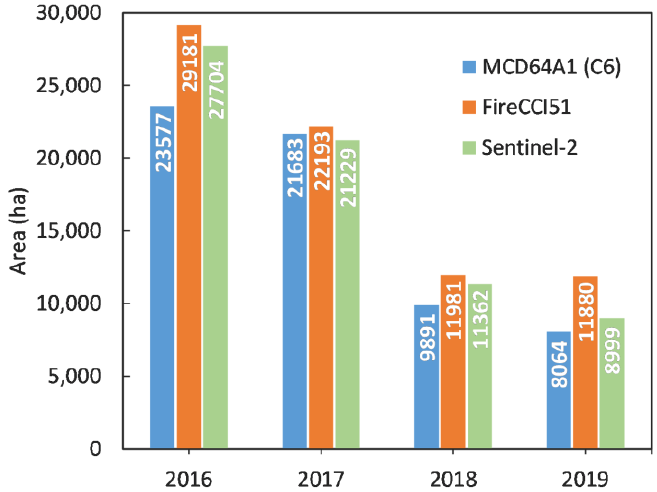
Figure 3. The annual total burned area (in hectares) reported for Greece by MCD64A1 C6, FireCCI51 and Sentinel-2 datasets.